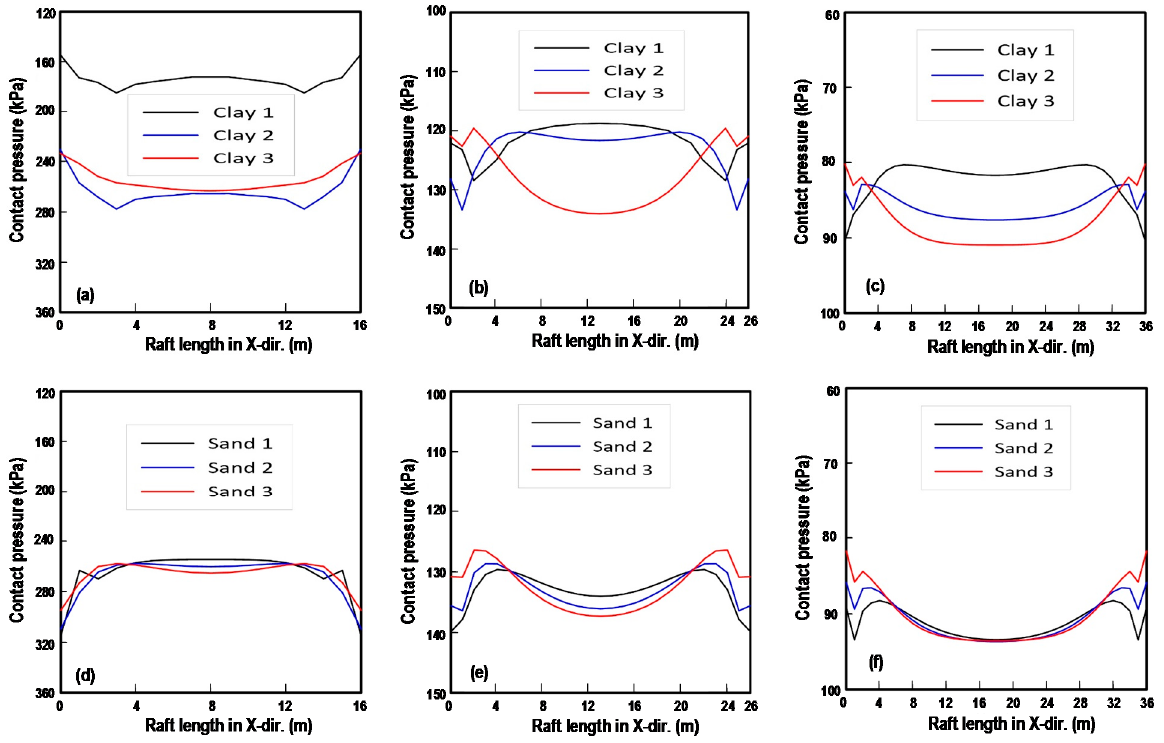
Figure 6. Contact pressure under square raft foundations with different dimensions: ( a ) 16 m, ( b ) 26 m, ( c ) 36 m in clays; ( d ) 16 m, ( e ) 26 m, ( f ) 36 m in sands. ( c ) 36 m in clays; ( d ) 16 m, ( e ) 26 m, ( f ) 36 m in